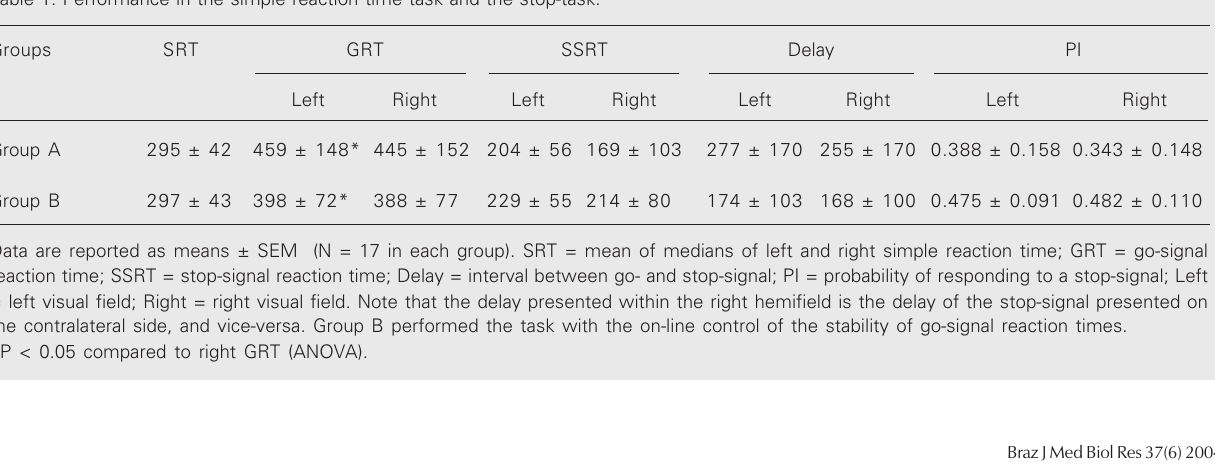
Table 1. Performance in the simple reaction time task and the stop-task. Groups SRT GRT SSRT Delay PI Left Right Left Right Left Right Left Right Group A